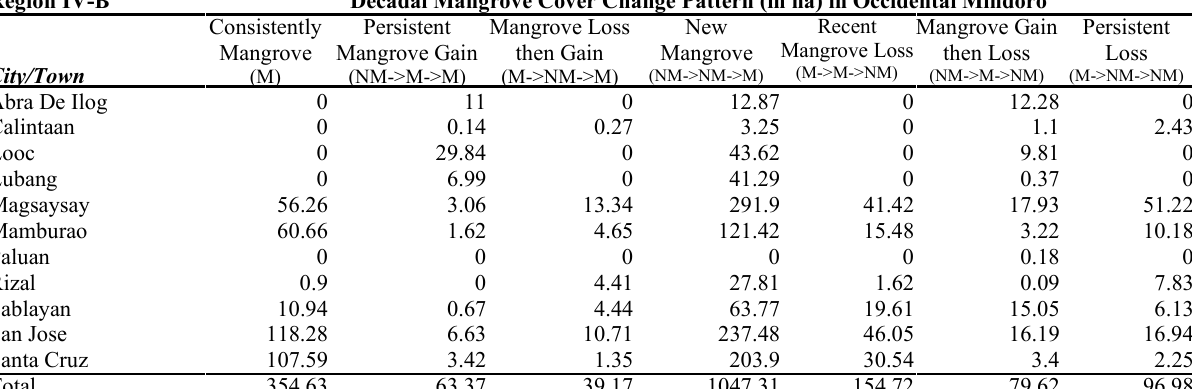
Table 8. Decadal Mangrove cover change pattern (in ha) in Occidental Mindoro. Note: M symbolizes the existence of mangroves, NM